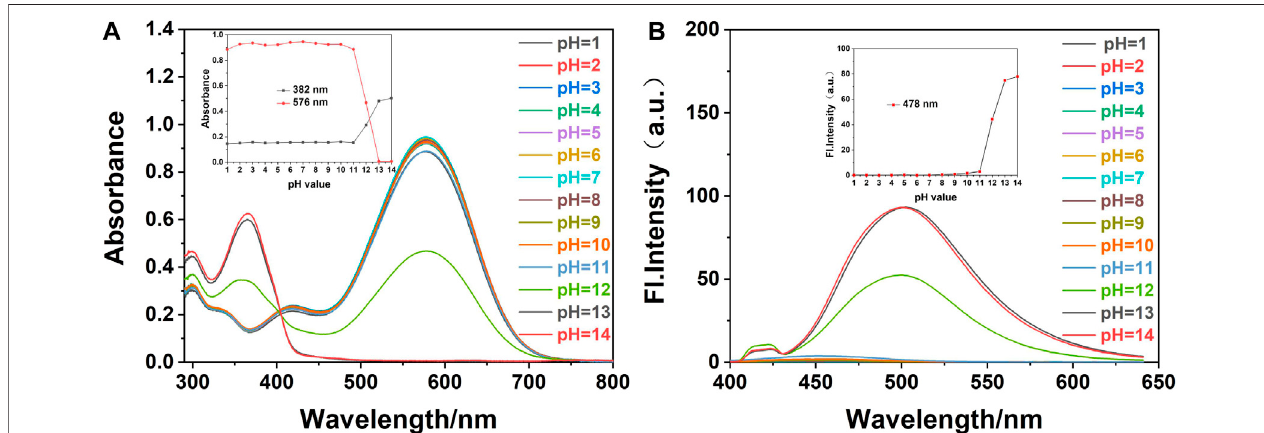
FIGURE 2 | (A) The UV-Vis and (B) fl uorescence spectra of fl uorescence probe W (20 μ M) in EtOH/water (VEtOH/VH2O = 3/2) at different pH values ( λ ex/ λ em = 378nm/479 nm,slit:5/5 nm,andvoltage:500 v).Inset: (A) effectofdifferentpHvaluesontheabsorbanceofprobeWat382and576 nm. (B) In fl uenceofpHvalueson fl uorescence probe W at 478 nm.